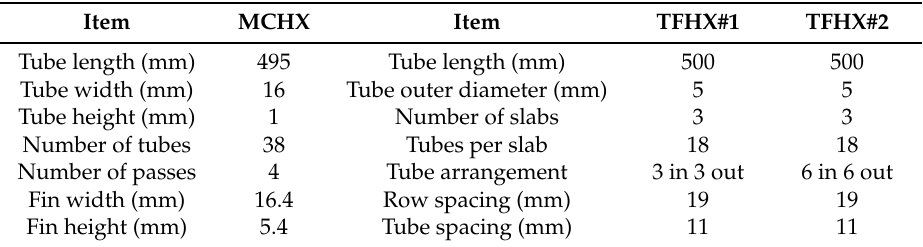
Table 5. Parameters of heat exchanger